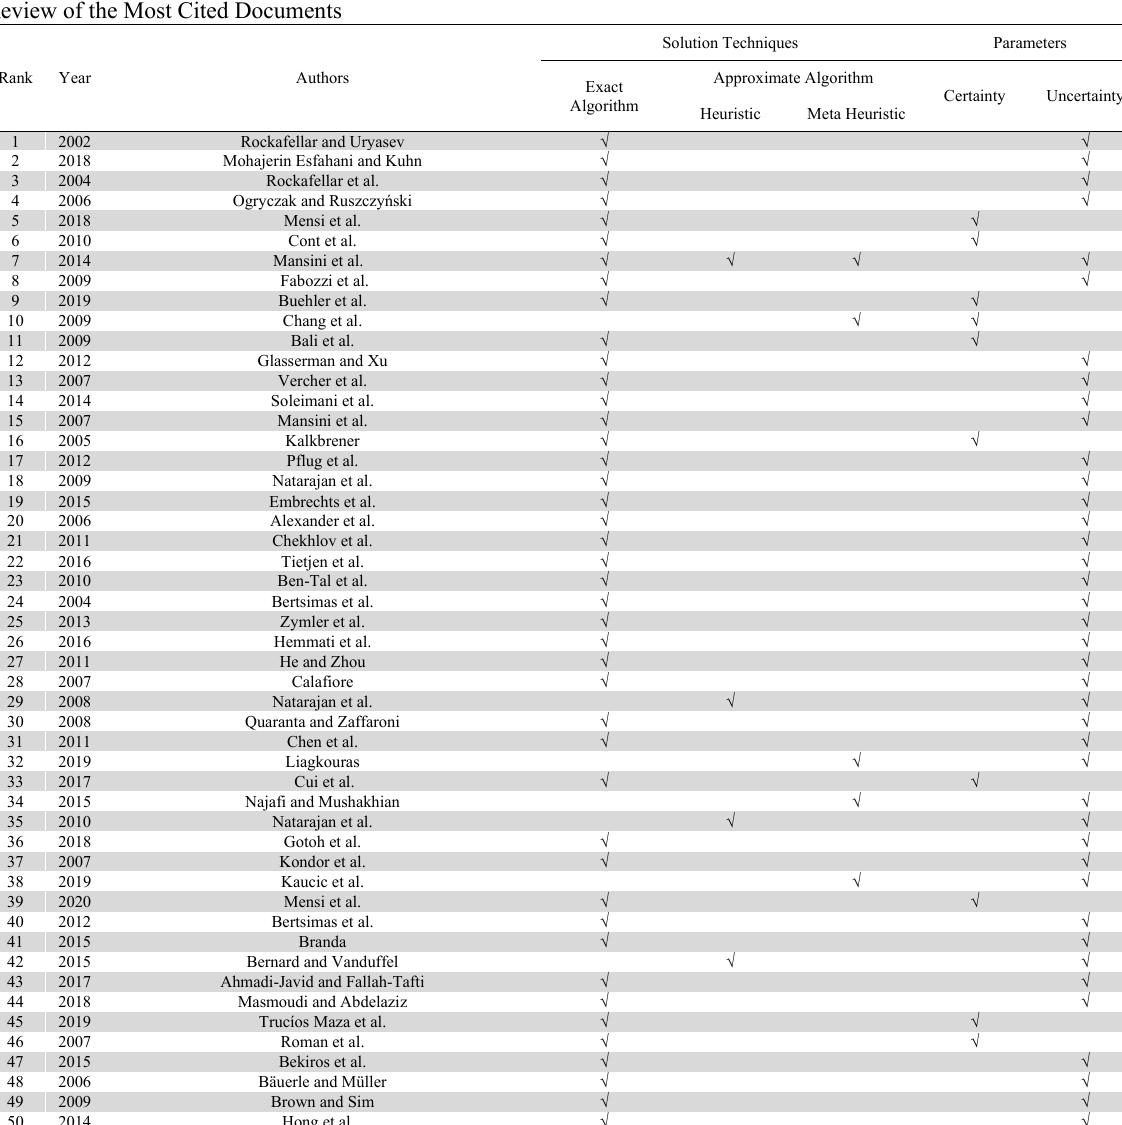
Certainty Uncertainty